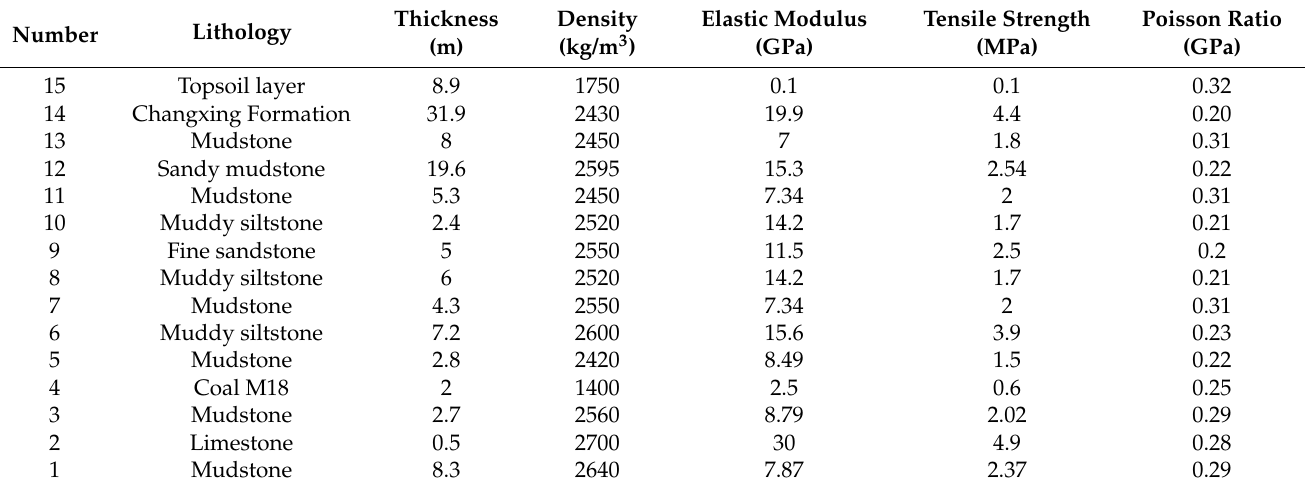
Table 1. Basic physical and mechanical parameters of coal and rock mass.